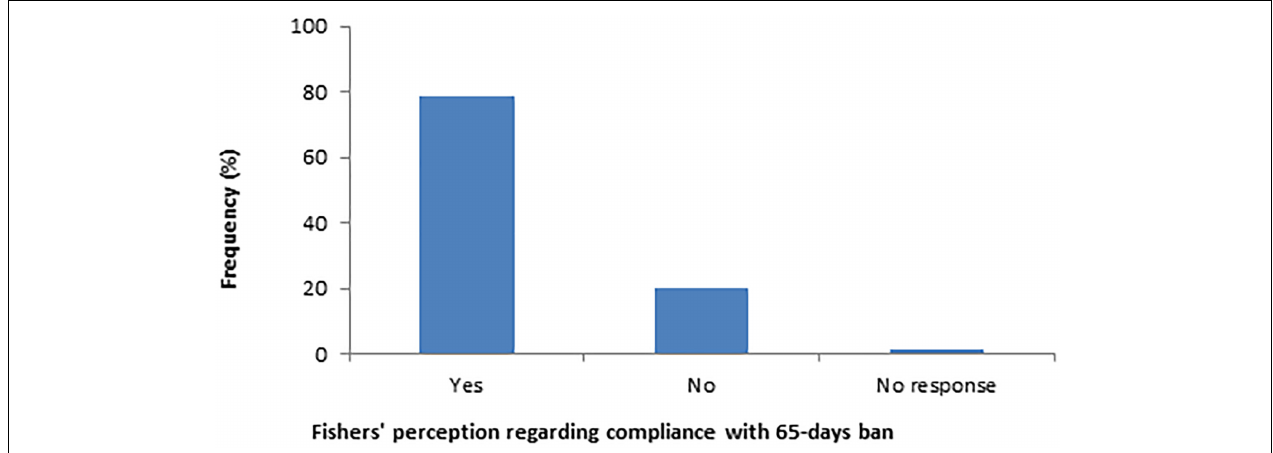
FIGURE 2 | Perceptions of the surveyed fishers’ of complying with the seasonal fishery closure.